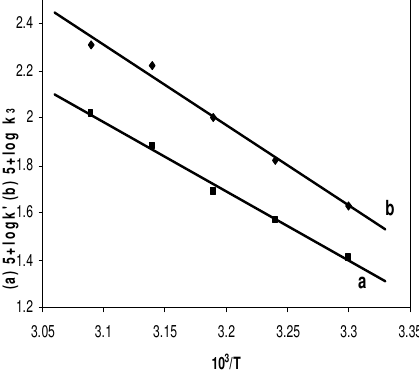
Figure 3 . A Plot of 10 3 /T versus (a) 5+log k’ (b) 5+log k